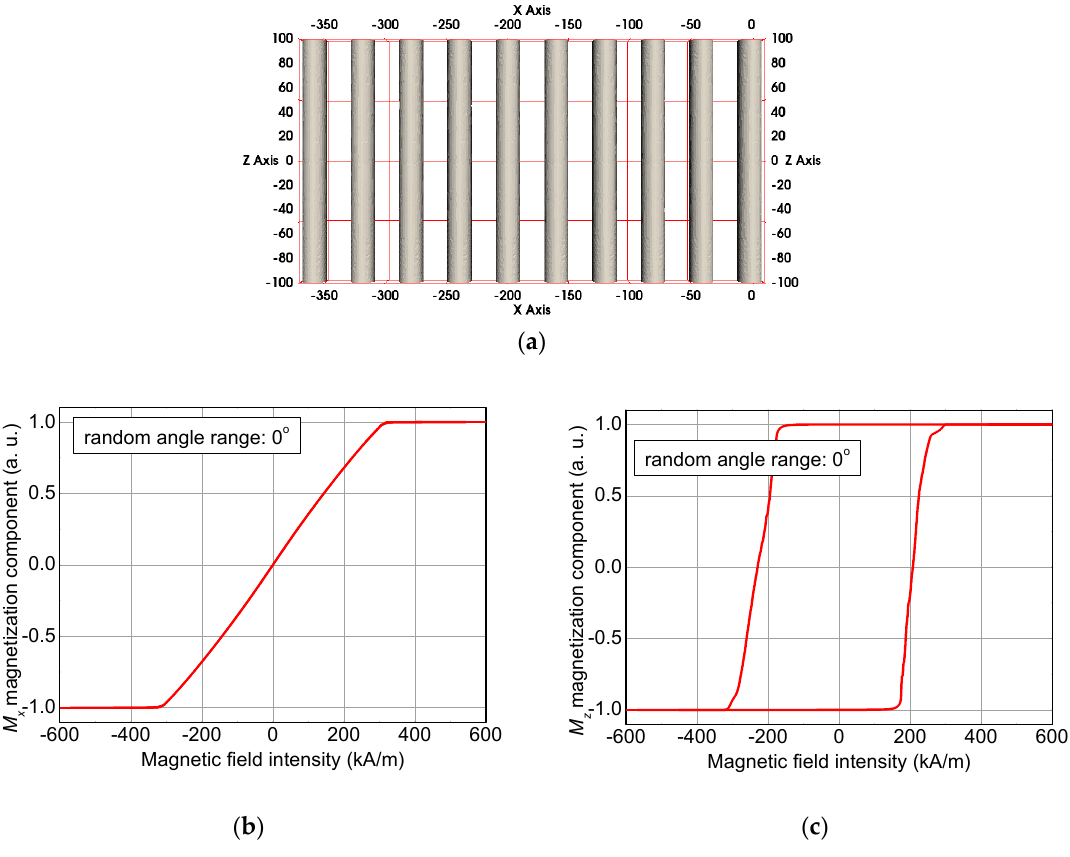
Figure 12. ( a ) Definition of the axes, magnetization components, ( b ) M x , and ( c ) M z in the non-random case of 0° possible deviation of the fiber orientation from the z-orientation.